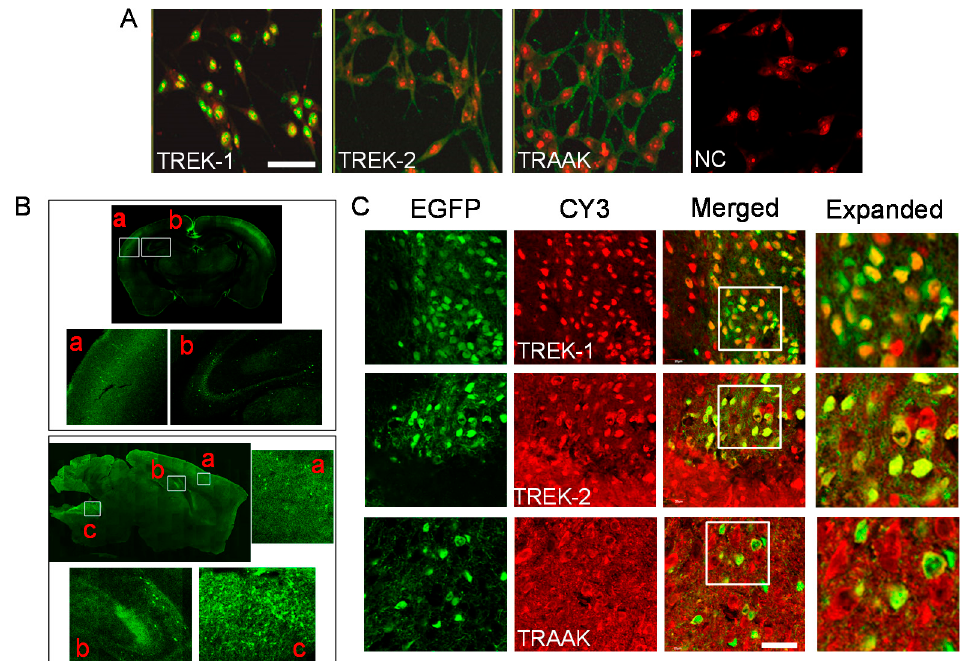
Figure 2. Expression of TREK/TRAAK in GABAergic neurons. ( A ) Localization of TREK-1, TREK-2, and TRAAK proteins in B35 cells. Cells were immunostained with anti-TREK-1, -TREK-2, or -TRAAK antibodies, and subjected to propidium iodide (PI) staining for nuclear staining. The merged image was output as an overlay of green fluorescence (FITC) and red PI-stain images. In the negative control (NC) group, the primary antibody was omitted. ( B ) The expression pattern of GABAergic neurons in the brain obtained from the GAD67-EGFP transgenic mice. The upper panel and lower panel present coronal section and sagittal section images, respectively. In the coronal and sagittal section images, a , b , and c represent the cortex, hippocampus, and medulla, respectively. ( C ) Co-localized TREK/TRAAK signals and GAD67-GFP signals in the medulla. GABAergic neurons expressed EGFP in green. The indicated antigen was immunostained red using CY3. EGFP and CY3 signals were merged in yellow (merge). An expanded view of the white box in the merged column is presented on the right side. Scale bar, 40 μ m.